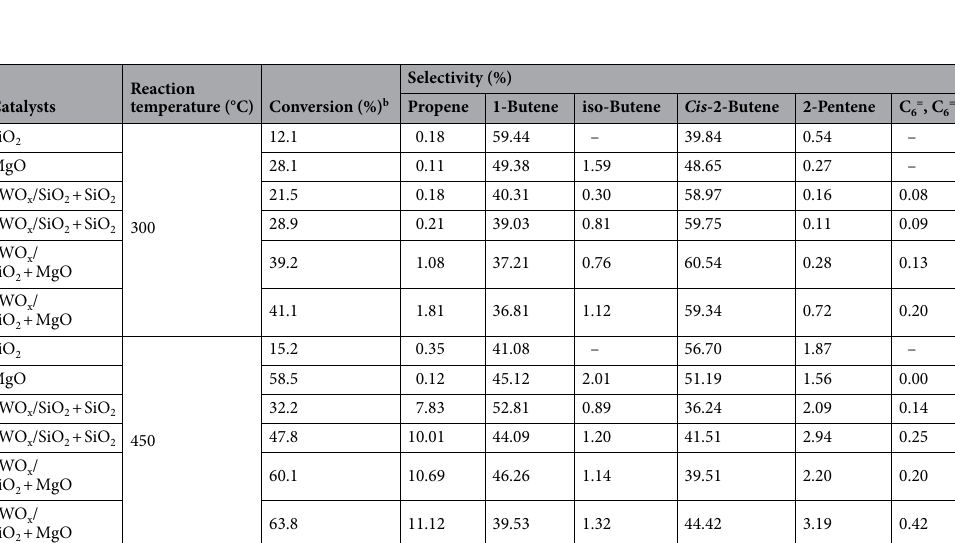
Figure 1. Difference reaction pathways on 9WO x /SiO 2 . The temperature programmed from 50 to 500 °C for reaction testing to observe the depending reaction pathways. The experiment was tested with 4% ethene and 2% trans -2-butene on 9WO x /SiO 2 catalyst (WHSV = 0.21 h −1 ; P = 0.1 MPa).